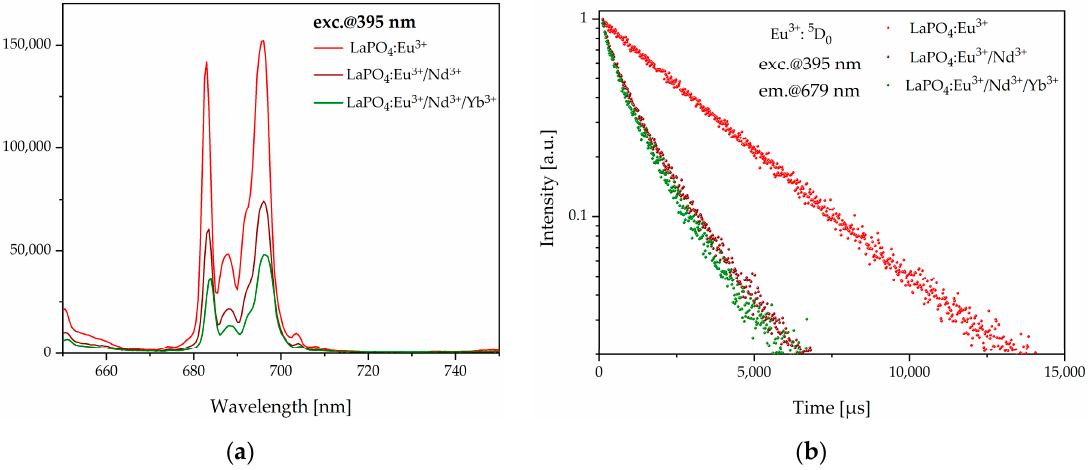
Figure 7. Luminescence spectra of LaPO 4 :Eu 3+ , LaPO 4 :Eu 3+ /Nd 3+ , and LaPO 4 :Eu 3+ /Nd 3+ /Yb 3+ excited at 395 nm ( a ) and luminescence decay curves from Eu 3+ : 5 D 0 ( λ exc = 395 nm) of LaPO 4 :Eu 3+ , LaPO 4 :Eu 3+ /Nd 3+ , and LaPO 4 :Eu 3+ /Nd 3+ /Yb 3+ samples ( b ).